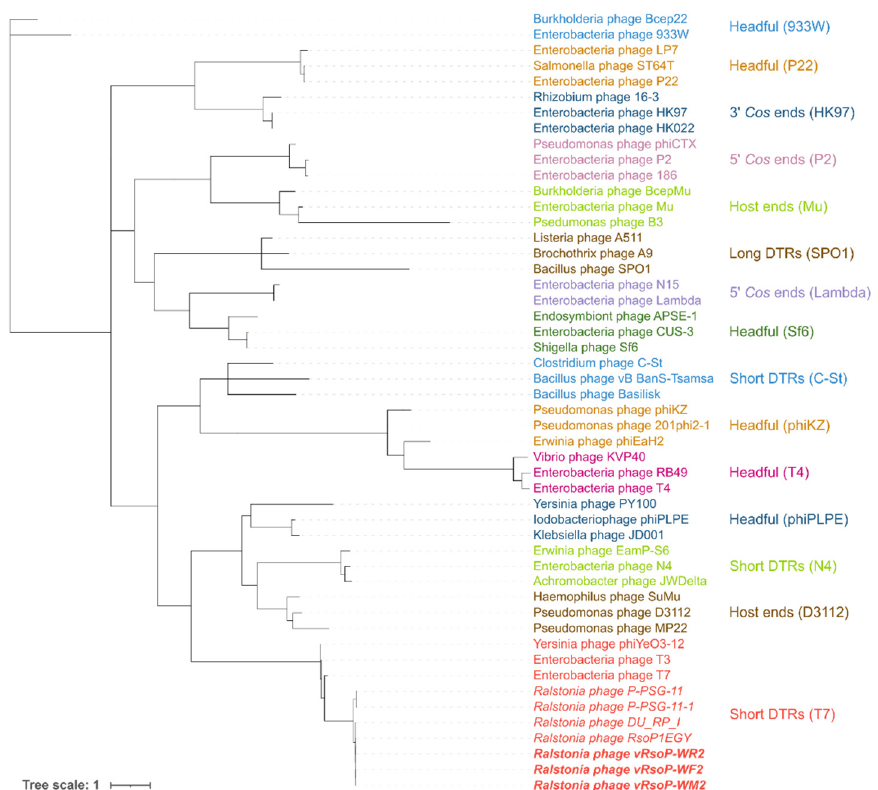
Figure 8. Phylogenetic tree of phage terminase large subunit (terL) protein of European water phages vRsoP-WF2, vRsoP-WM2 and vRsoP-WR2 (in bold and italics) with a selection of closely related R. solanacearum (in italics) and 50 reference phages. The name of each phage or prophage is indicated at each terminal node while the type of DNA packaging of each group, as in [57], is shown coloured. The lower part of the figure, in red, shows that the European R. solanacearum phages and their closely related phages cluster with the T7-like reference phages that use direct terminal repeats (DTR) as a packaging mechanism.